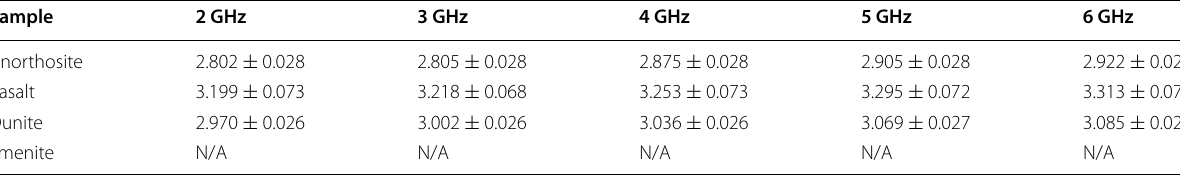
Table 2 Permittivity of the samples having 40% porosity at − 20 ◦ C